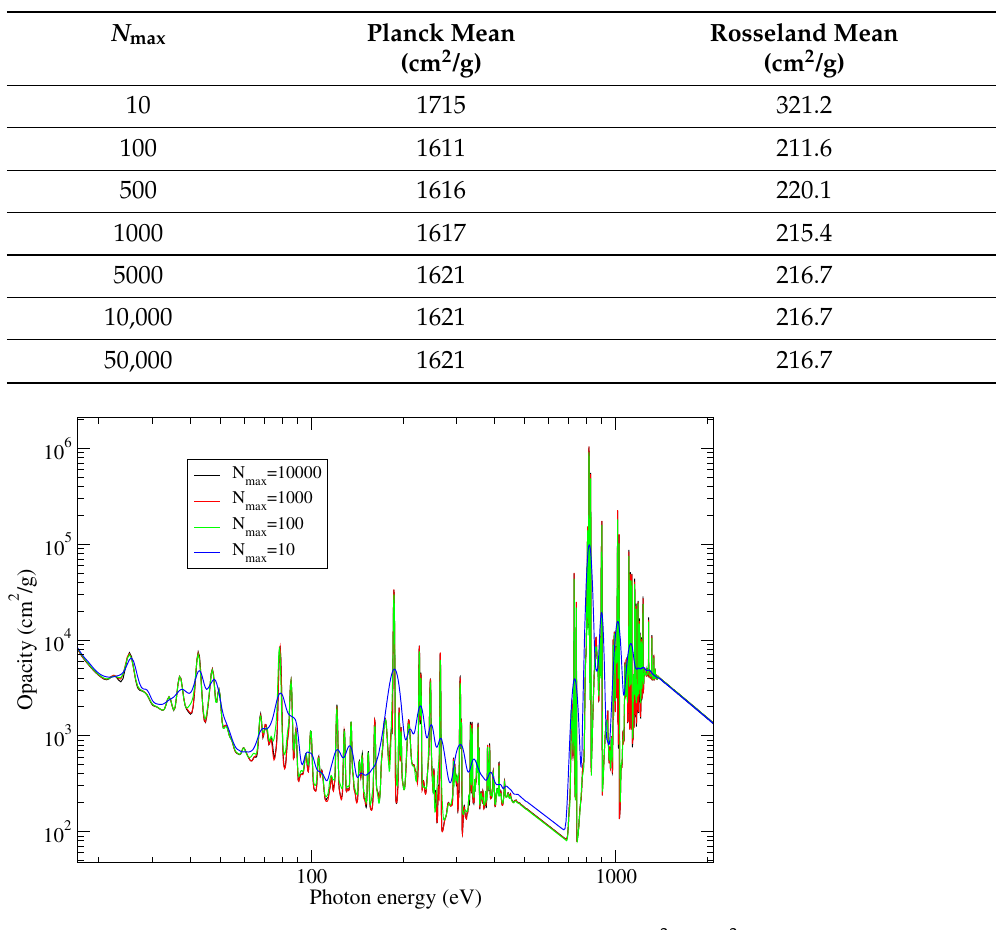
Table 2. Planck and Rosseland means in the different cases displayed in Table 1. The average ionization is 15.45.